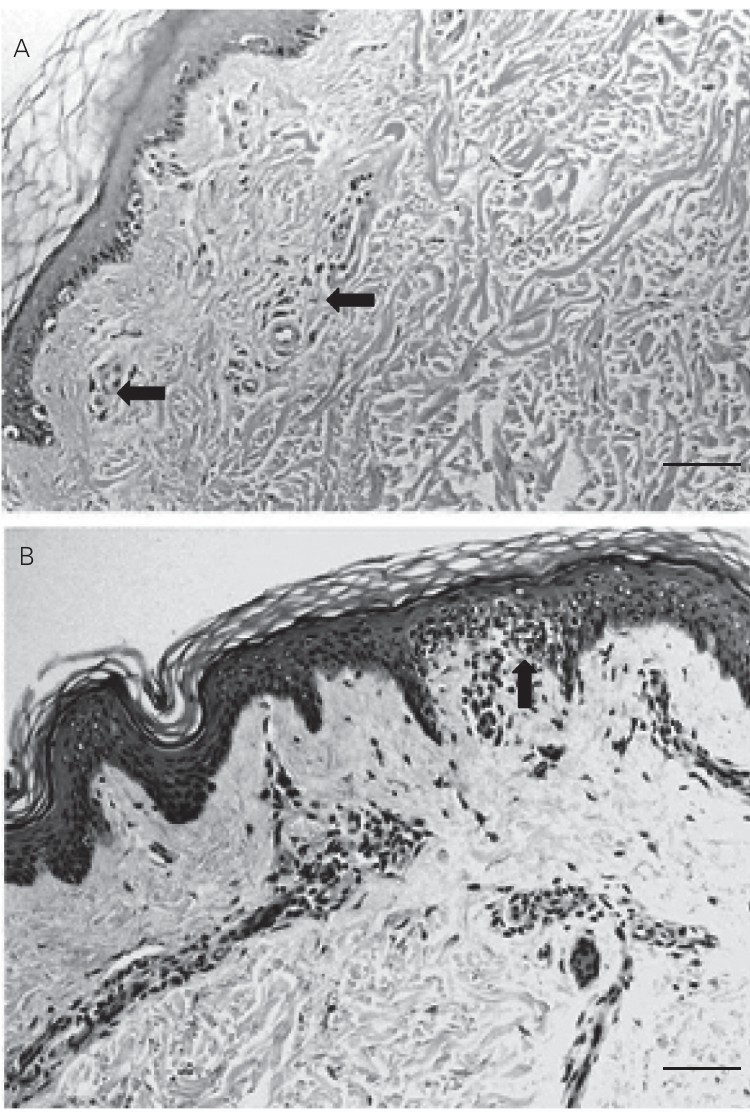
Figure 1. Normal skin biopsies obtained from HIV+ patients. Two different patterns of superficial dermal cellular infiltrate are shown. A , There are rare cells in the inflammatory infiltrate (arrows). Hematoxylin-eosin staining, 200X. B , The dermal cellular infiltrate is mostly perivascular and consists largely of lymphocytes with discrete extension into the dermis (arrow). Hematoxylin-eosin staining, Original magnification, 200X. Bars = 80